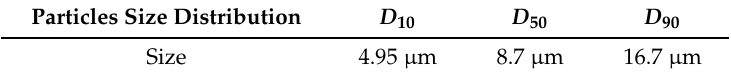
Table 1. Characteristics of the Inconel 718 powder.